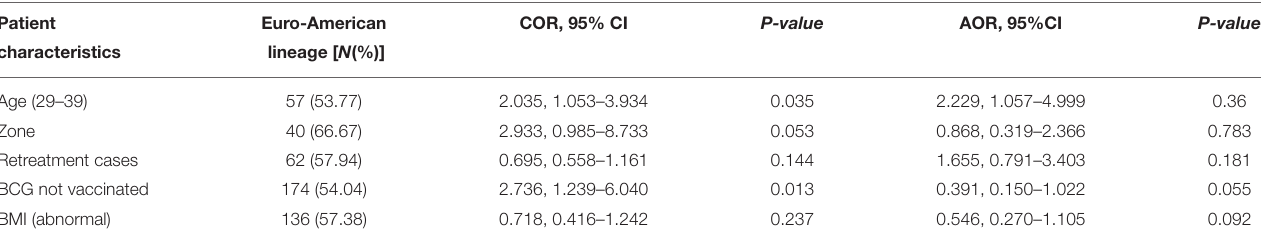
TABLE 4 | Association of patients’ socio-demographic characteristics and clinical history with Euro-American lineage compared to other major lineages ( n = 315).